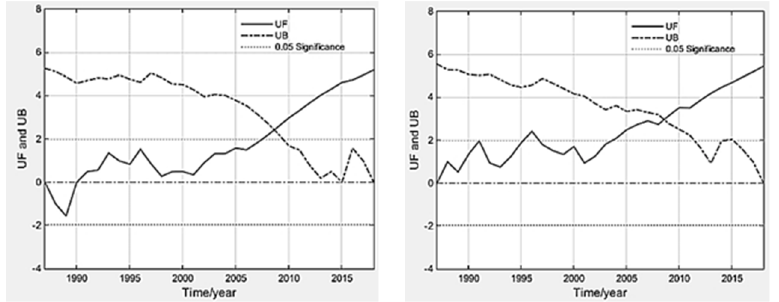
Figure 3. Abrupt point of NDVI in Wei and Jing River Basin during 1987–2018 (left-hand side shows abrupt detection in Wei River Basin, right-hand side shows that in Jing River Basin).